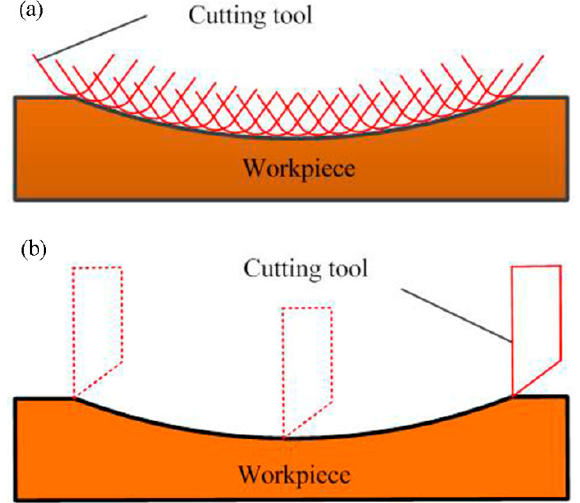
Figure 2. Schematic of the forming method. ( a ) The axial direction; ( b ) the circumferential direction.